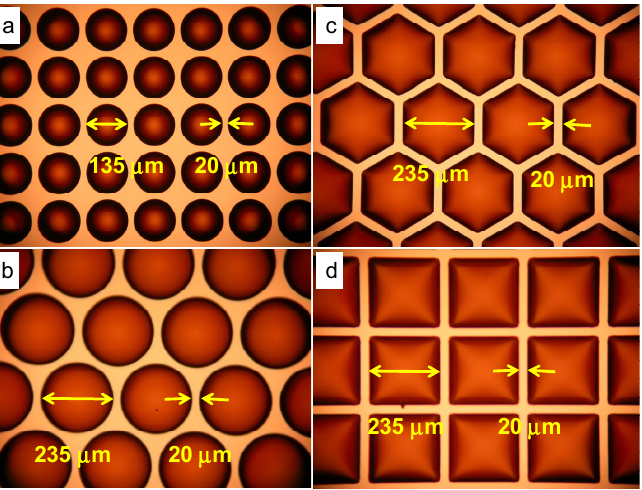
Figure 4. The picture of the photoresist of: (a) circular lens square grid MLA, (b) circular lens hexagonal grid MLA, (c) hexagonal lens MLA, and (d) square lens MLA after thermal